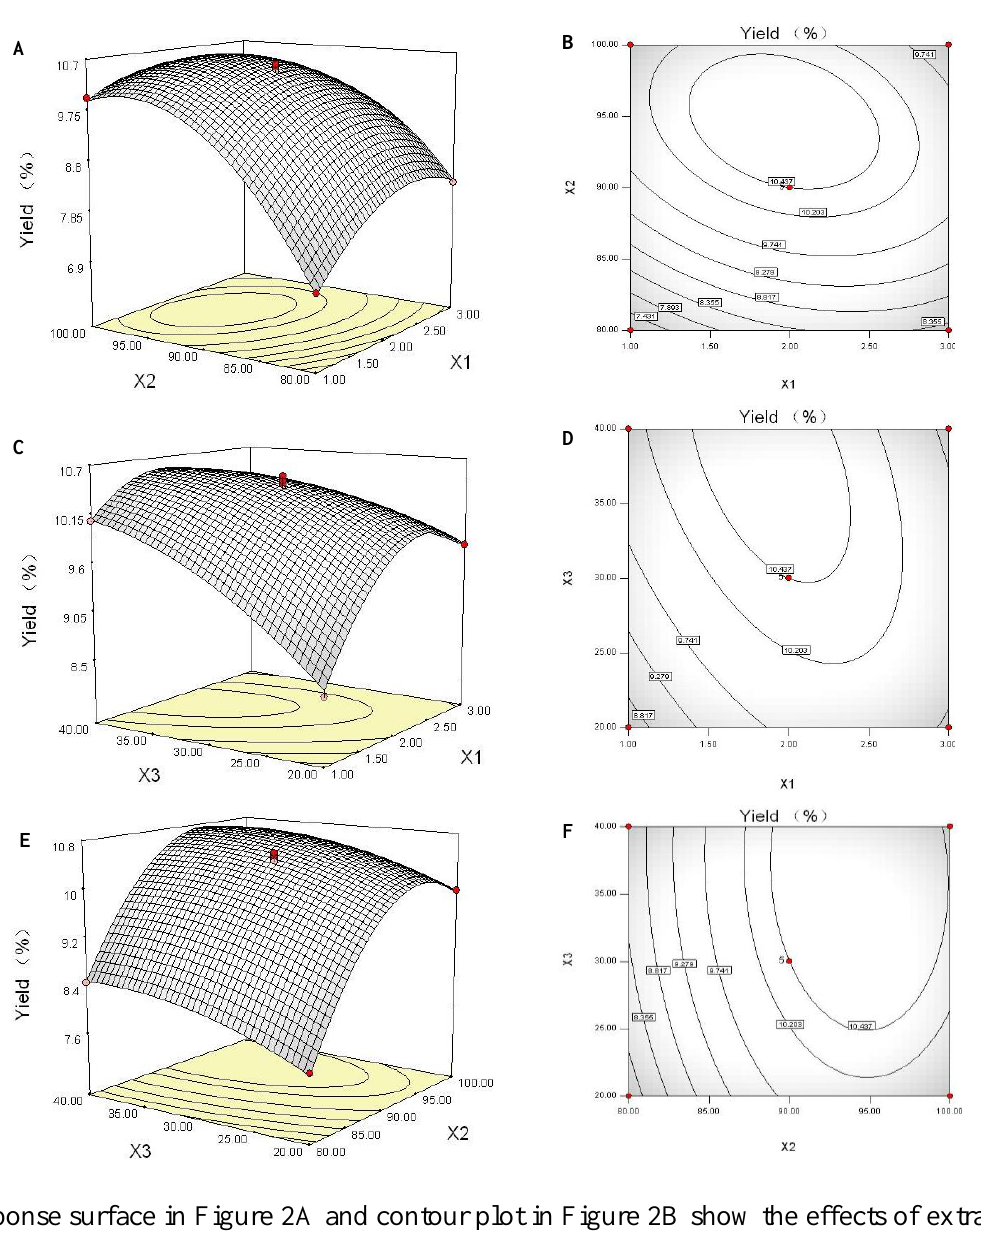
diagram [32]. Thus, the optimal ranges of the two tested variables for obtaining maximum WPS yield were also calculated as follows: extraction time as 1.40–2.39 h, and extraction temperature